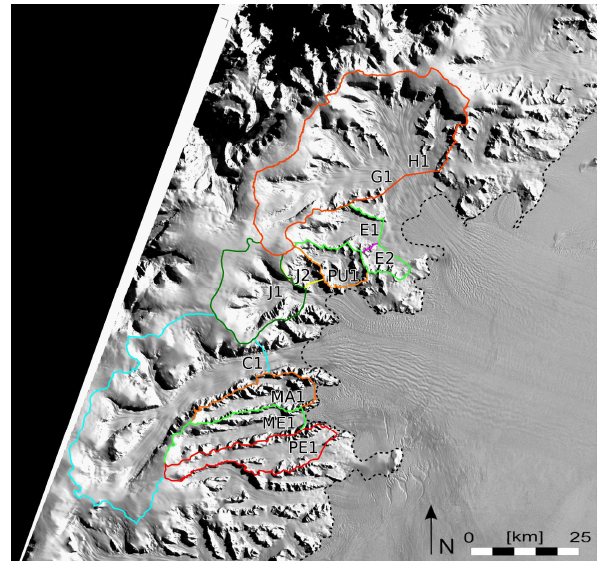
Figure 2. Landsat Thematic Mapper Image of 1 March 1986 with boundaries of the glacier basins above Larsen-B embayment. The labels refer to the gates of the glaciers specified in Table 2. The black dotted line corresponds to the grounding line.